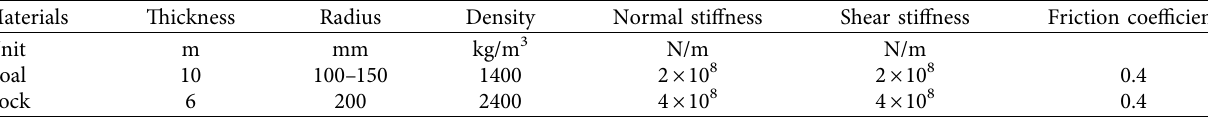
Figure 5: The initial PFC 2D model of drawing experiments. Table 1: Mechanical parameters of the top coal and gangue particles.